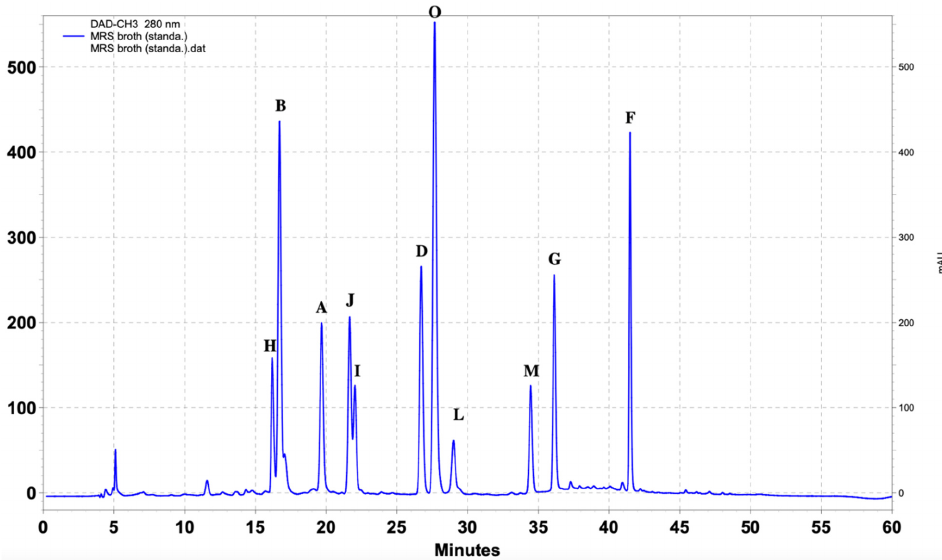
Figure 2. Chromatogram at 280 nm of 11 standard mixes (50 ppm; 10 mL injection) of previously reported antifungal compounds from LAB prepared in water–methanol (90/10) and MRS broth